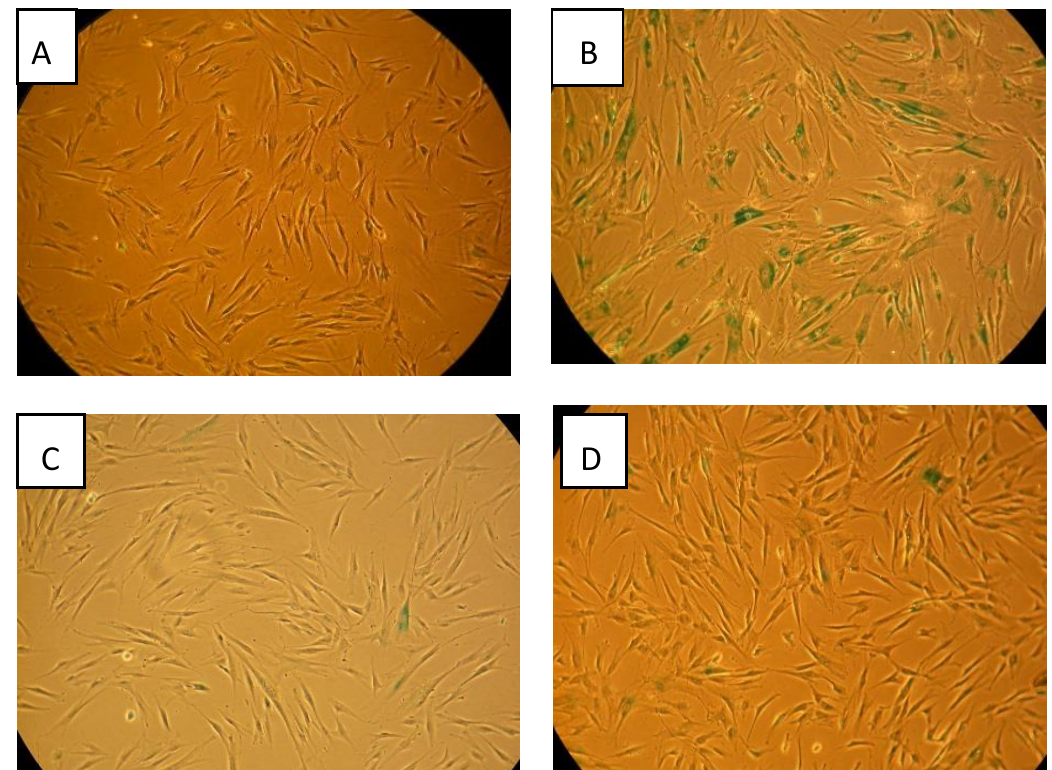
Figure 6. FSF210316B cells, 15 days following X-ray irradiation with senescence-associated beta-galactosidase staining (blue) in 0 Gy control ( A ), 10 Gy x-irradiated cells ( B ), 0.1 Gy ( C ), and 2Gy ( D ).